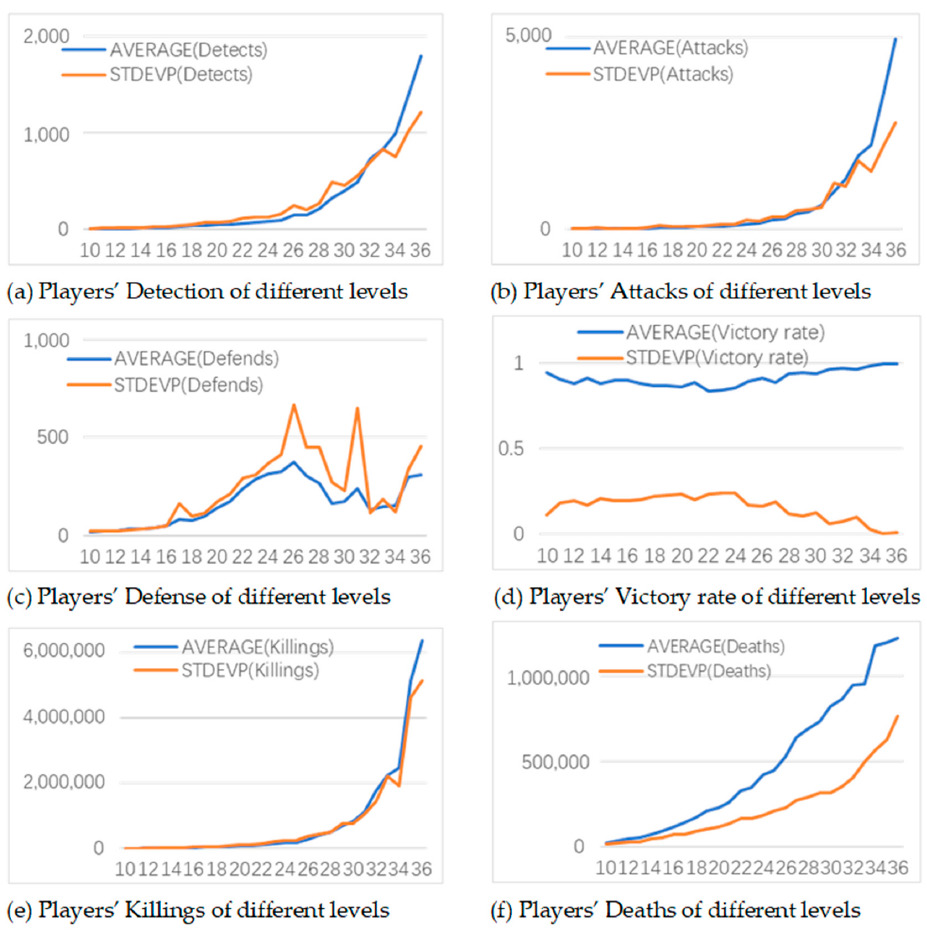
Figure 2. Six kinds of players’ in-game behaviors, varying according to their level, ranging from 10.